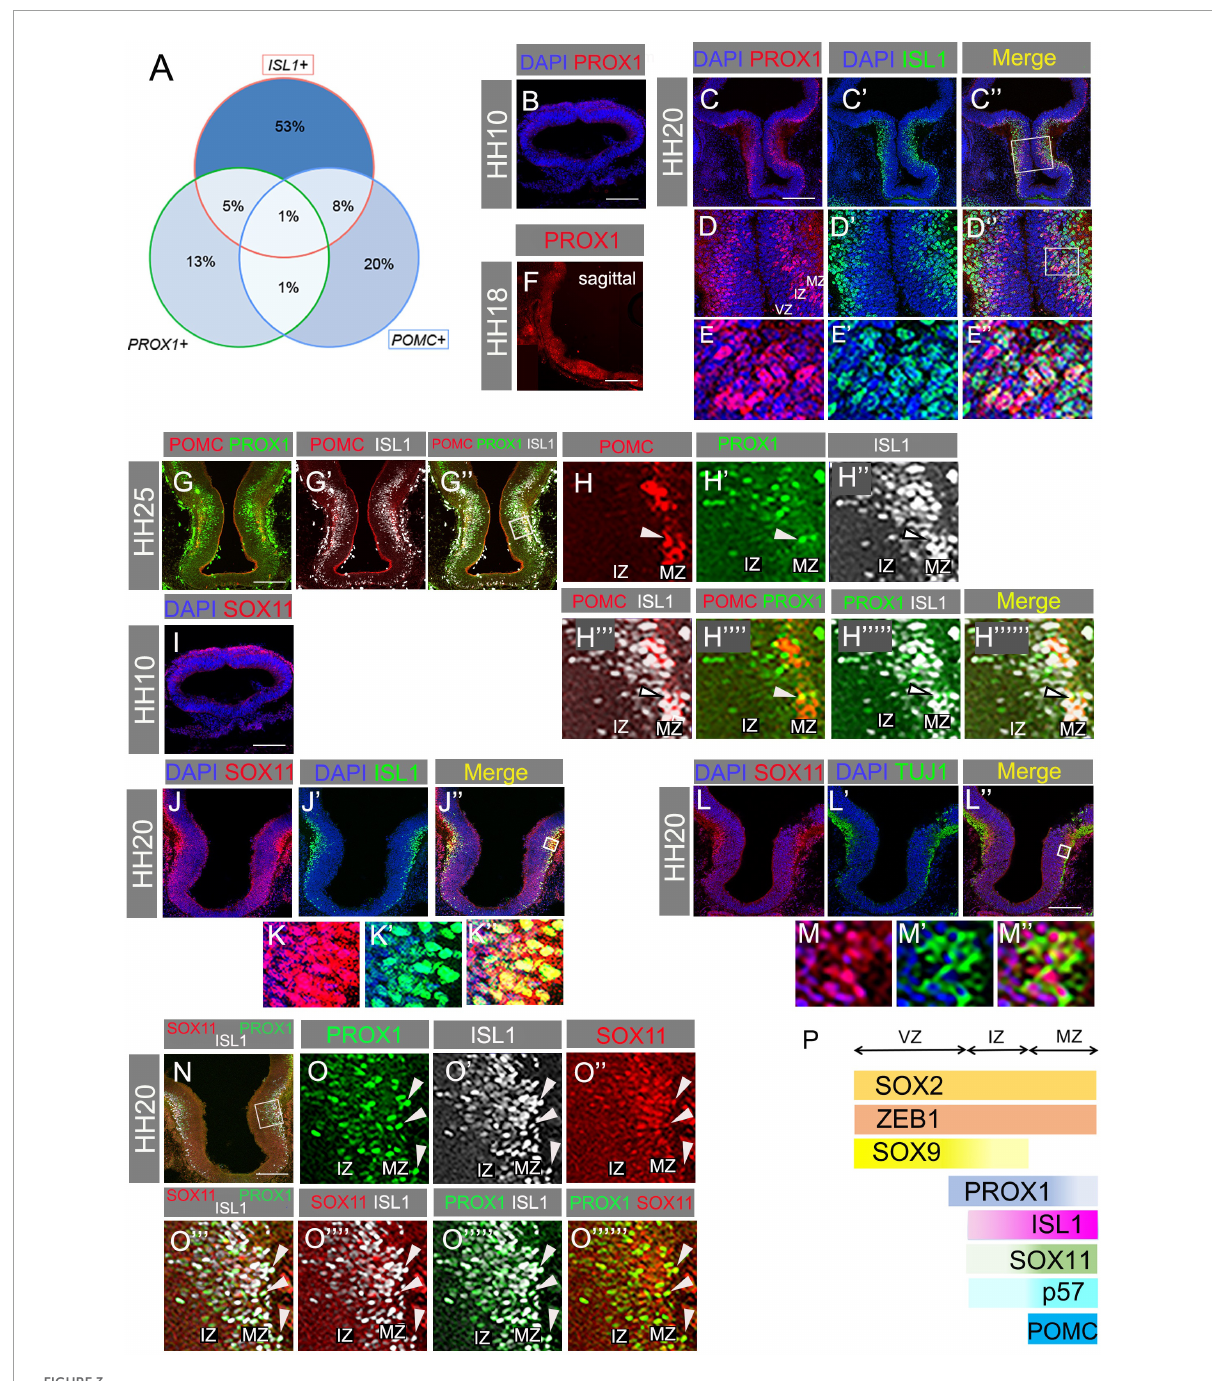
FIGURE3 (A) Venn diagram showing percentage of ISL1-, PROX1-, or POMC-expressing cells that are single, double, or triple positive for these markers. (B) Transverse section through HH10 hypothalamus with antibody labelling for PROX1. (C–E”) Transverse section through hypothalamus at HH20 immunolabelled for PROX1 and ISL1. Box in panel (C”) indicates area expanded in panels (D–D”) . Box in panel (D”) indicates area expanded in panels (E–E”) . (F) Sagittal section showing PROX1 mRNA detected by HCR at HH18. (G–H”””) Transverse section through HH25 hypothalamus with antibody co-labelling for POMC, PROX1, and ISL1. Box in panel (G”) indicates region expanded in panels (H–H”””) . Arrowheads indicate co-expressing cells. (I–J”) Transverse section through HH20 hypothalamus with antibody co-labelling for SOX11 and ISL1. Box in panel (J”) indicates region expanded in panels (K–K”) . (K–L”) Transverse section through HH20 hypothalamus with antibody co-labelling for SOX11 and TUJ1, and merged. Box in panel (K”) indicates region expanded in panels (L–L”) . (M) Transverse sections through